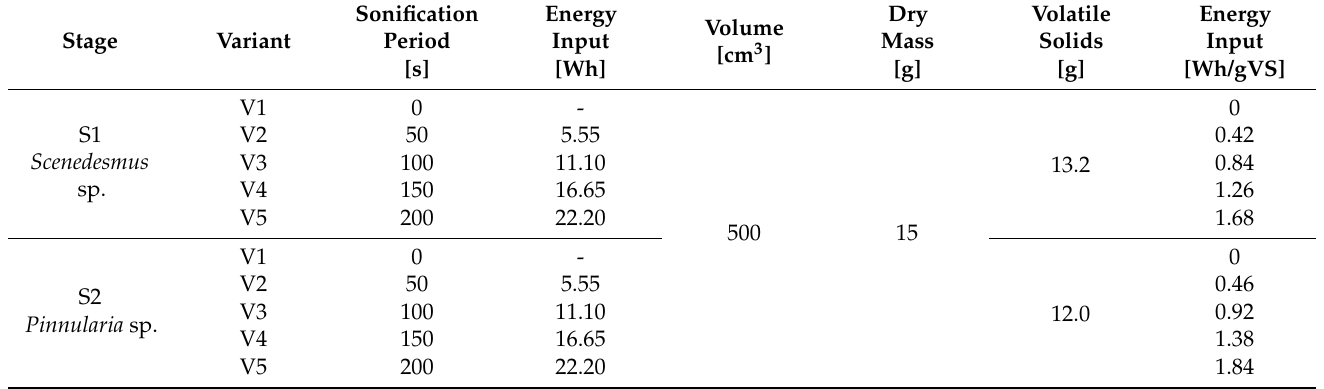
Table 4. Experimental